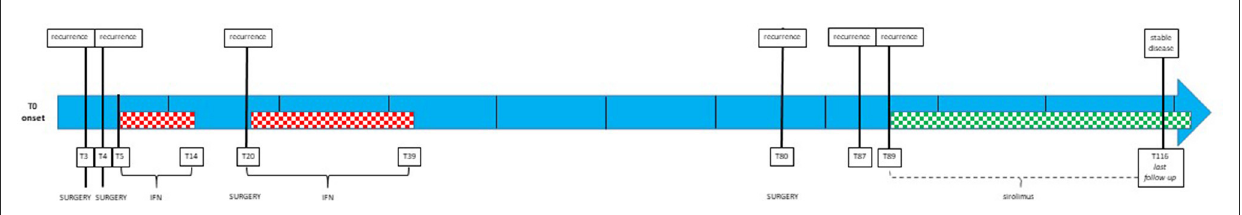
FIGURE2 The treatment timeline of the patient. Single-line units in the last 12 months. Dotted squared space: systemic therapy [interferon (IFN), red; sirolimus, green].